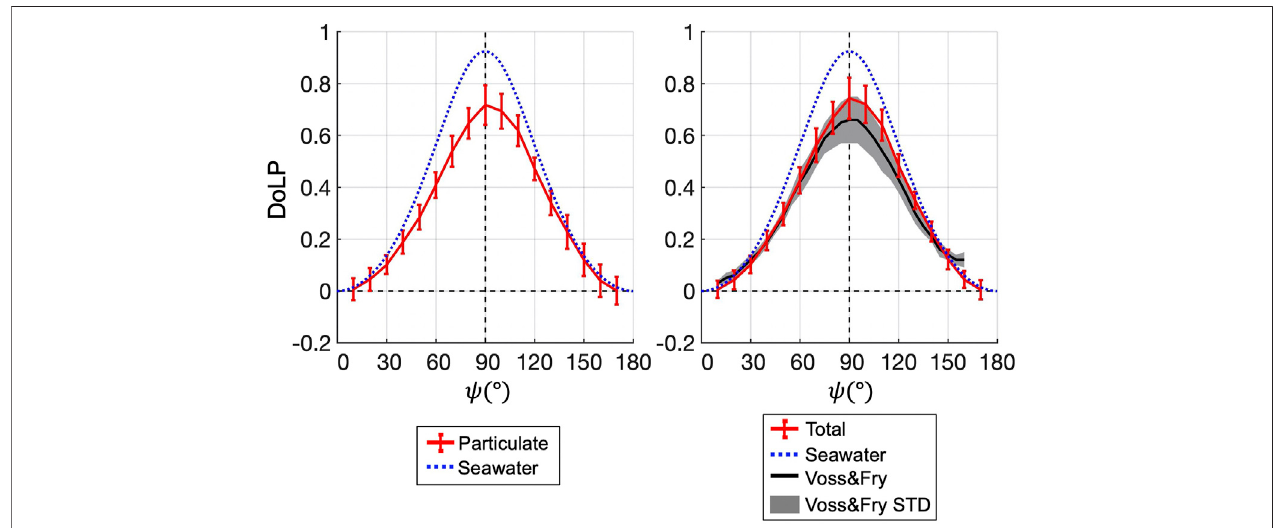
FIGURE 8 | Left: The ensemble average particulate DoLP from Figure 7 is plotted as the red curve with error bars indicating standard deviation at 17 angles. SeawaterDoLPat20 ° Candasalinityof35 pptisthebluedottedcurve.Right:Sameasleftpanel,exceptthattheparticulateDoLPisreplacedwithtotalDoLP(particulate plusseawater)fromthisstudy.TheglobalmeantotalDoLPfromtheVossandFrystudyisoverlaidastheblackcurve.GreyareaisthestandarddeviationoftheVossand Fry DoLP.